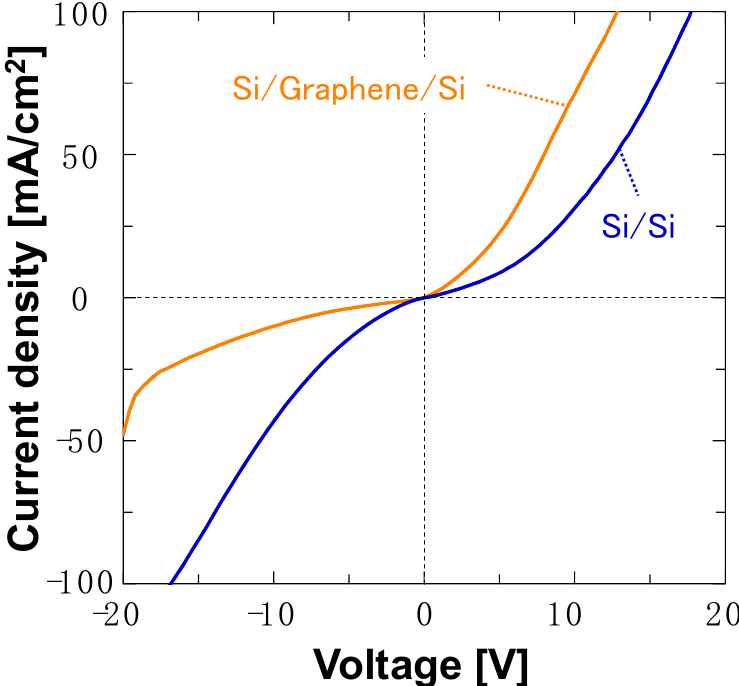
Figure 7. Current-voltage characteristics of the Si/bilayer graphene/Si double heterostructure and corresponding Si/Si control structure with the same doping concentration (~1 × 10 16 cm − 3 ) in the Si wafer.